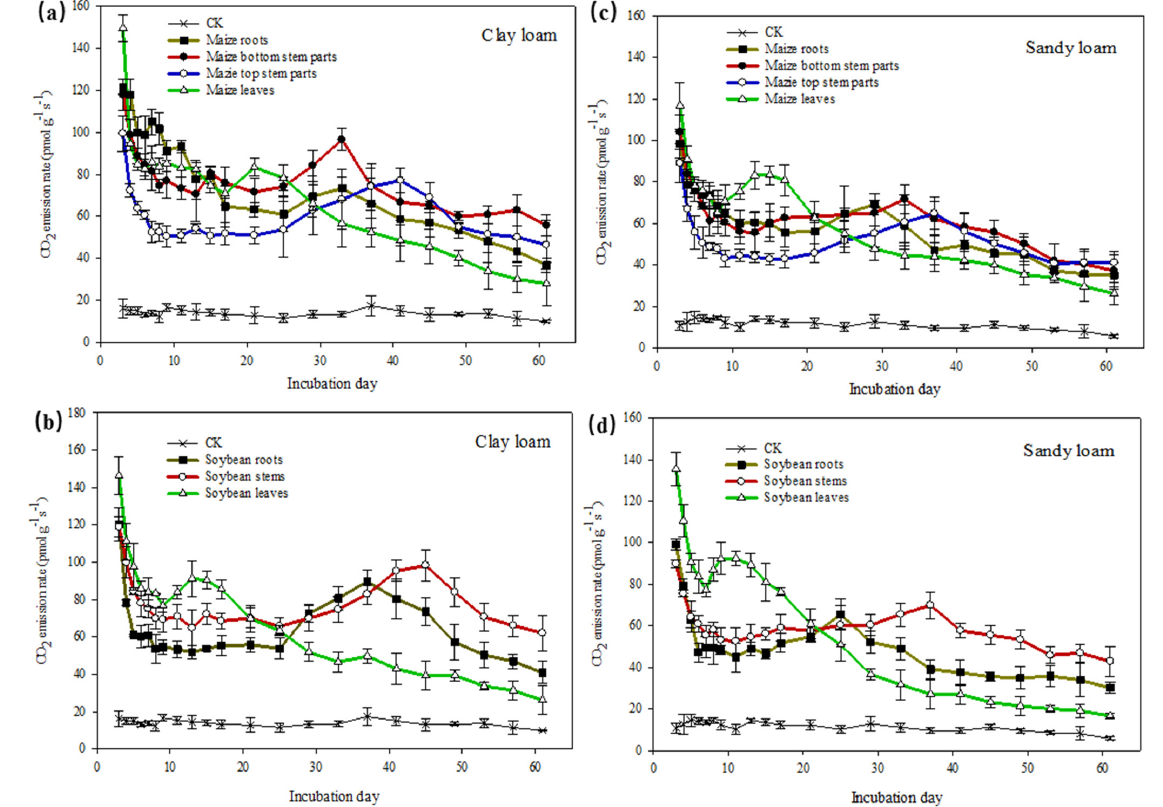
Leaves produced the highest cumulative CO 2 compared with other parts in both soils, and the differences were significant in the sandy loam ( p ≤ 0.05). Cumulative CO 2 emissions induced by different residue types showed similar results between the two soils while the emissions from the clay loam were 4.1~21% higher than that from the sandy loam in the early incubation period (21 days). In the whole incubation period of 61 days, cumulative CO 2 emissions showed large differences between the two soils (13%~39% higher from the clay loam than that from the sandy loam) (Figure 2). Across the seven residue types in the clay loam, soil with soybean stems produced the highest amount of CO 2 (413 μ mol·g − 1 ) followed by soil with maize bottom stem parts (398 μ mol·g − 1 ), whereas soil with soybean leaves produced the lowest amount (323 μ mol·g − 1 ). Across the four types of maize resi- dues, the maize top stem parts produced the lowest CO 2 in both soils, which were 19% Figure 1. CO 2 emission rates from clay loam amended with different residue parts of maize ( a ) and and 12% lower than bottom stem parts and roots, respectively, in the clay loam, and 16% soybean ( b ), and from sandy loam amended with different residue parts of maize ( c ) and soybean and 9.4% lower than bottom stem parts and leaves, respectively, in the sandy loam (Figure ( d ). Vertical bars are ± standard errors ( n = 4). CK, control, soil with no residue amendment. 2). Applying crop residues significantly increased cumulative CO 2 emissions ( p ≤ 0.05) compared with the control in both type of soils during the early incubation period (initial 21 days) and during the whole incubation period (61 days) (Figure 2). Cumulative CO 2 emissions at the two time periods (21 days vs. 61 days) showed different responses to residue addition. During the early period, maize top stem parts induced significantly lower cumulative CO 2 emission than the other maize parts and all soybean residue parts, whereas soybean roots produced lower CO 2 emission compared with its stems and leaves.